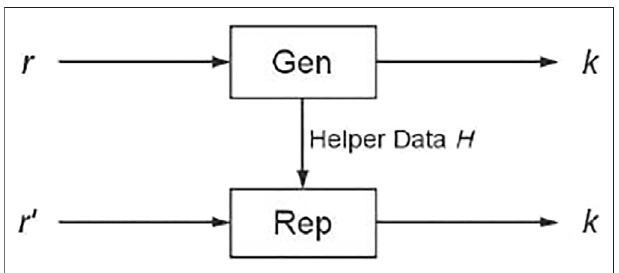
FIGURE 2 | Logic realization of the